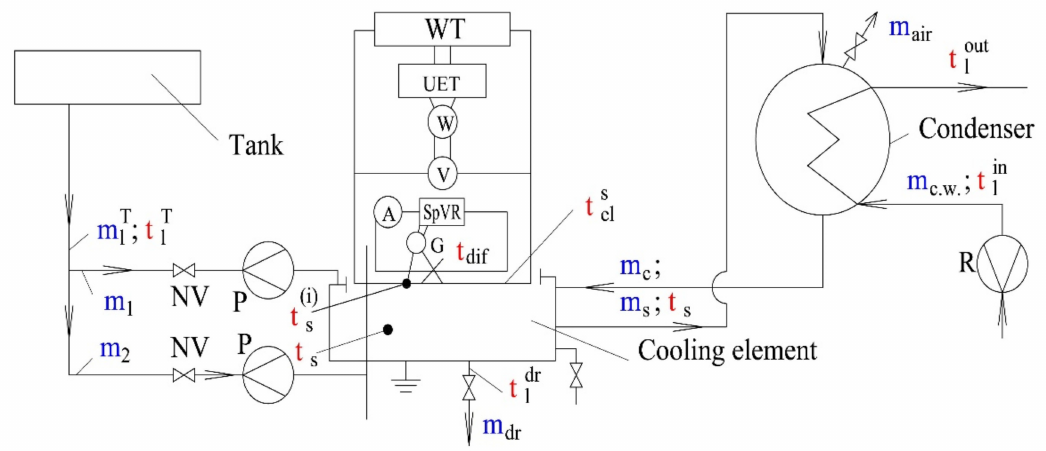
Figure 2. Experimental determination of heat fluxes on a heat exchange surface and capillary-porous structures (coating).